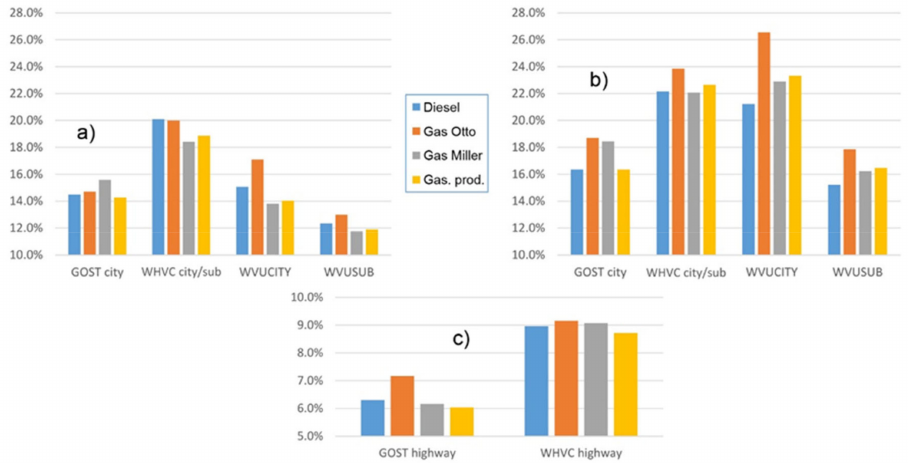
Figure 15. Calculated fuel economy of the HEV relative to the conventional vehicle: ( a ) city and suburban cycles, the start–stop was disabled; ( b ) city and suburban cycles, the start–stop was enabled; and ( c ) highway